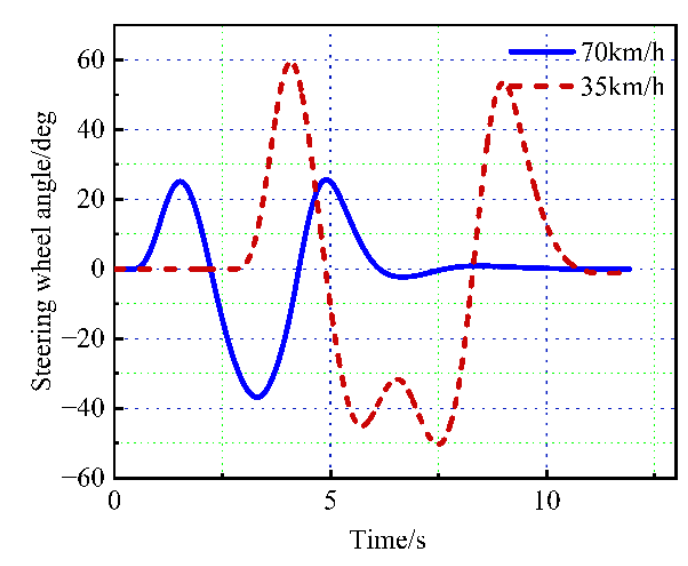
Figure 9. The steering wheel angle curve is smooth and continuous without oscillation and sudden change. The simulation results show that the generated path is available and conforms to the operating characteristics of human drivers.